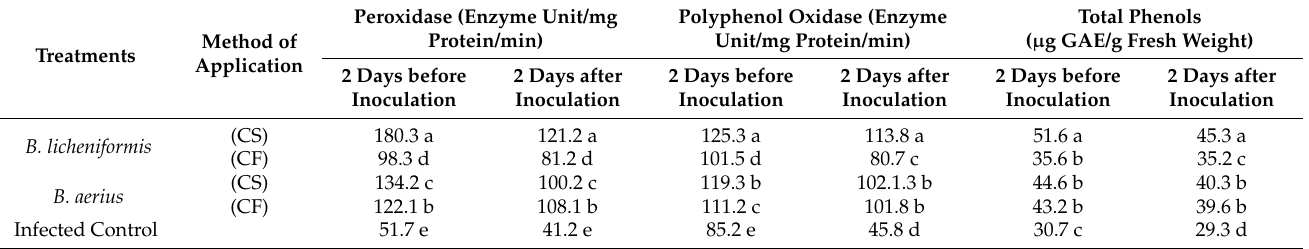
Table 6. Effect of Bacillus licheniformis and B. aerius treatments on biochemical changes of powdery mildew cucumber plants after 10 days from